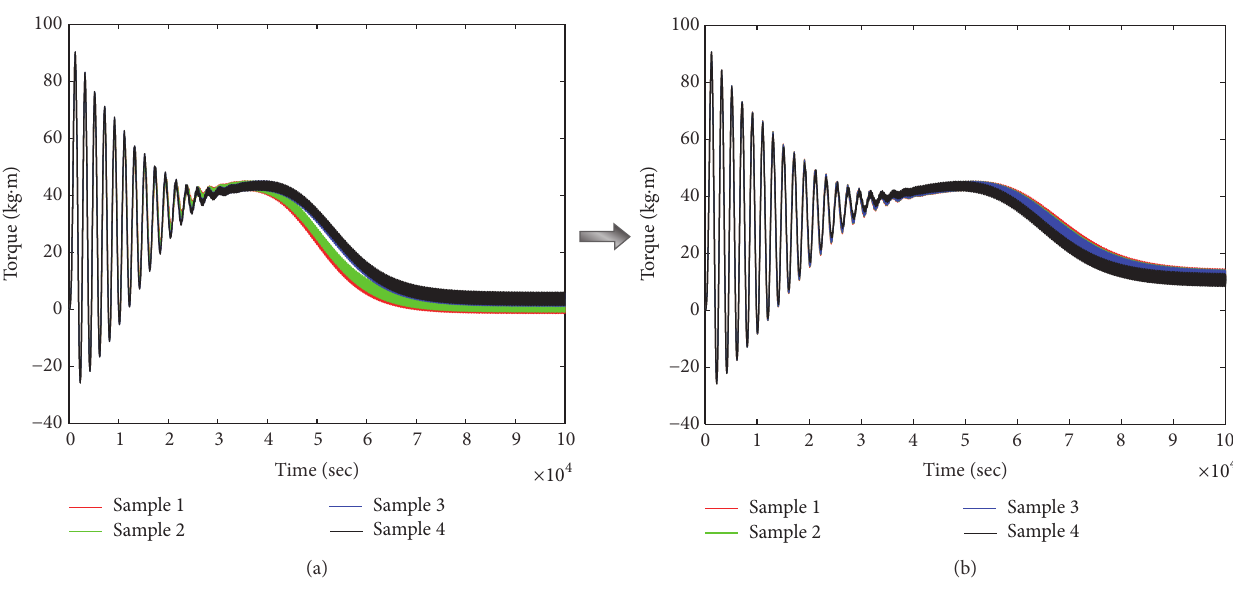
Figure 6: Rotor torque comparison of at (a) no-load and (b) rotor lock full load.